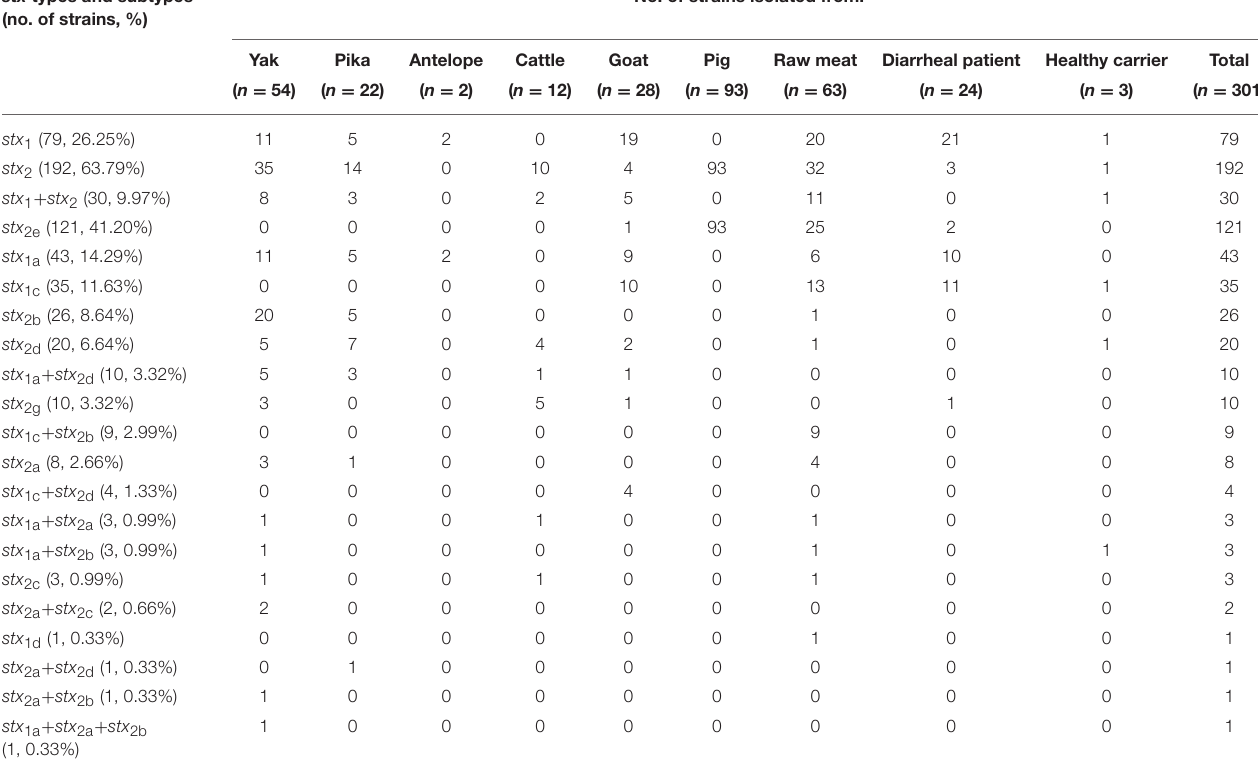
TABLE 3 | stx prevalence in relation to origin of